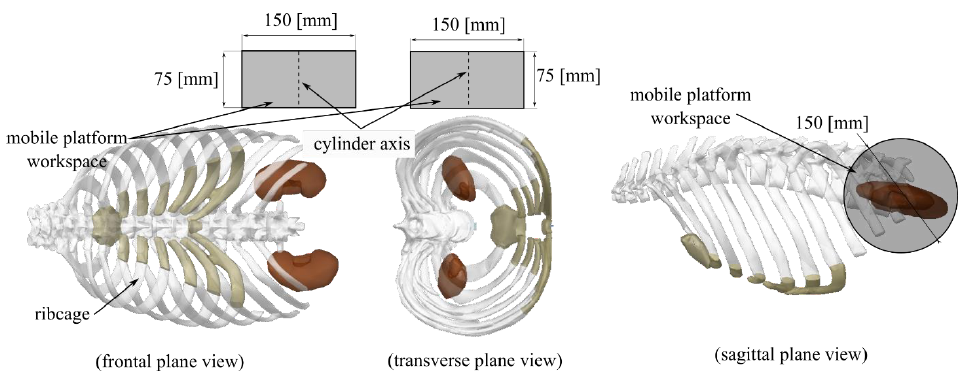
Figure 4. The proposed external workspace for the 6-DOF SILS robotic system (cylinder with radius 75 [mm] and height 75 [mm] and its position with respect to the ribcage).